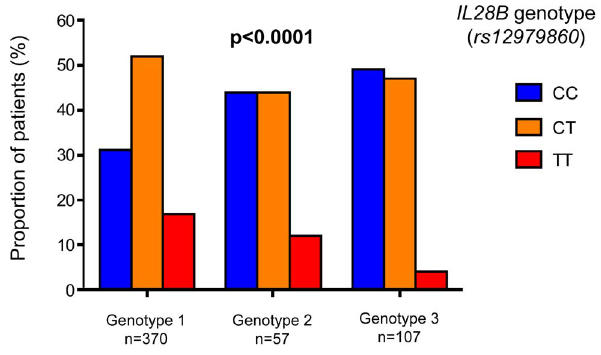
Figure 2. Frequency distribution of IL28B variants in relation to HCV genotypes 1-3 among treatment-naı¨ve patients. Chi- squared ( x 2 )-test was used to compare differences in distribution.